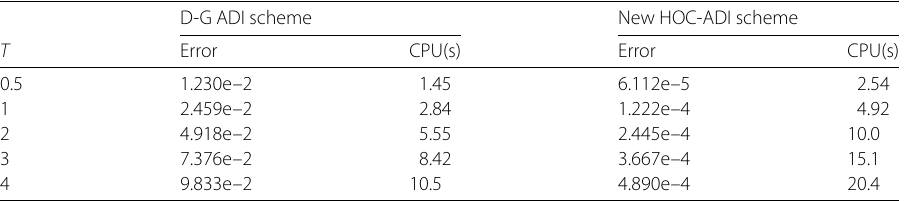
Table 2 Comparison of maximum errors at different time T for the equation in Example 1, h = 2 π /20, time step τ =